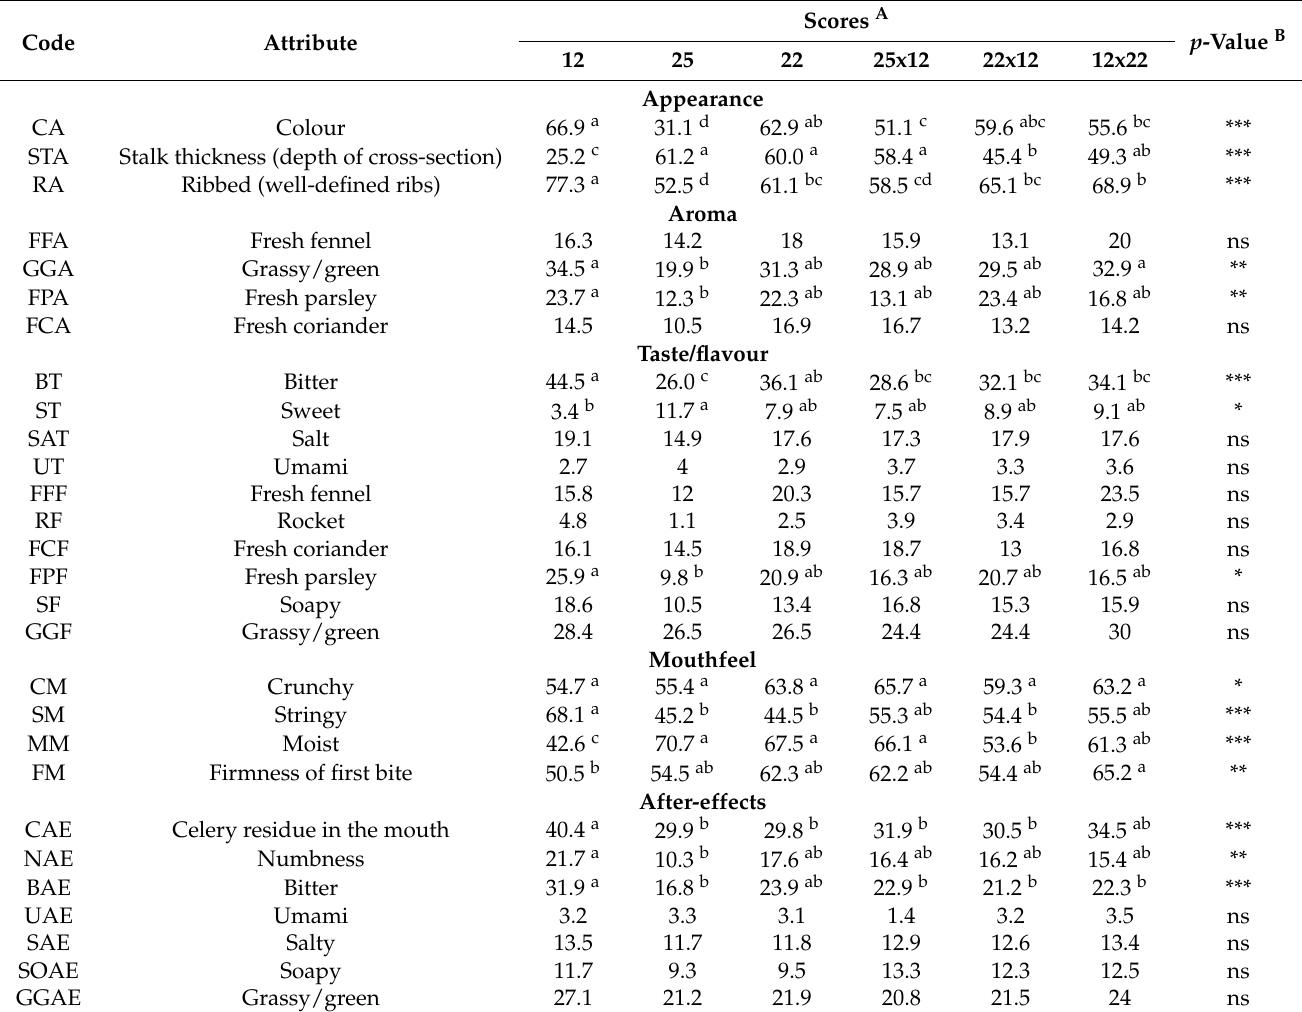
Table 2. Mean panel scores for sensory attributes of six celery